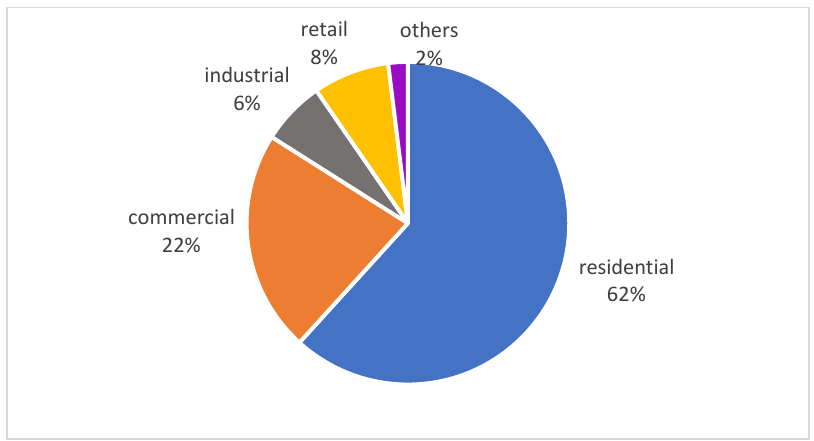
Figure 2. Distribution of coworking spaces related to the type of land use for non-peripheral areas.